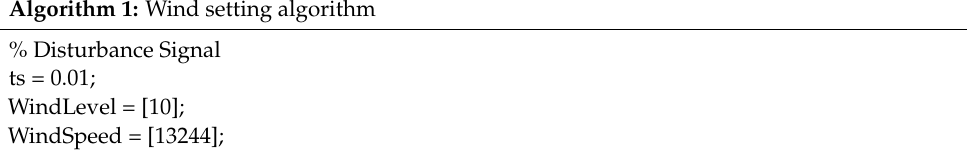
Algorithm 1: Wind setting